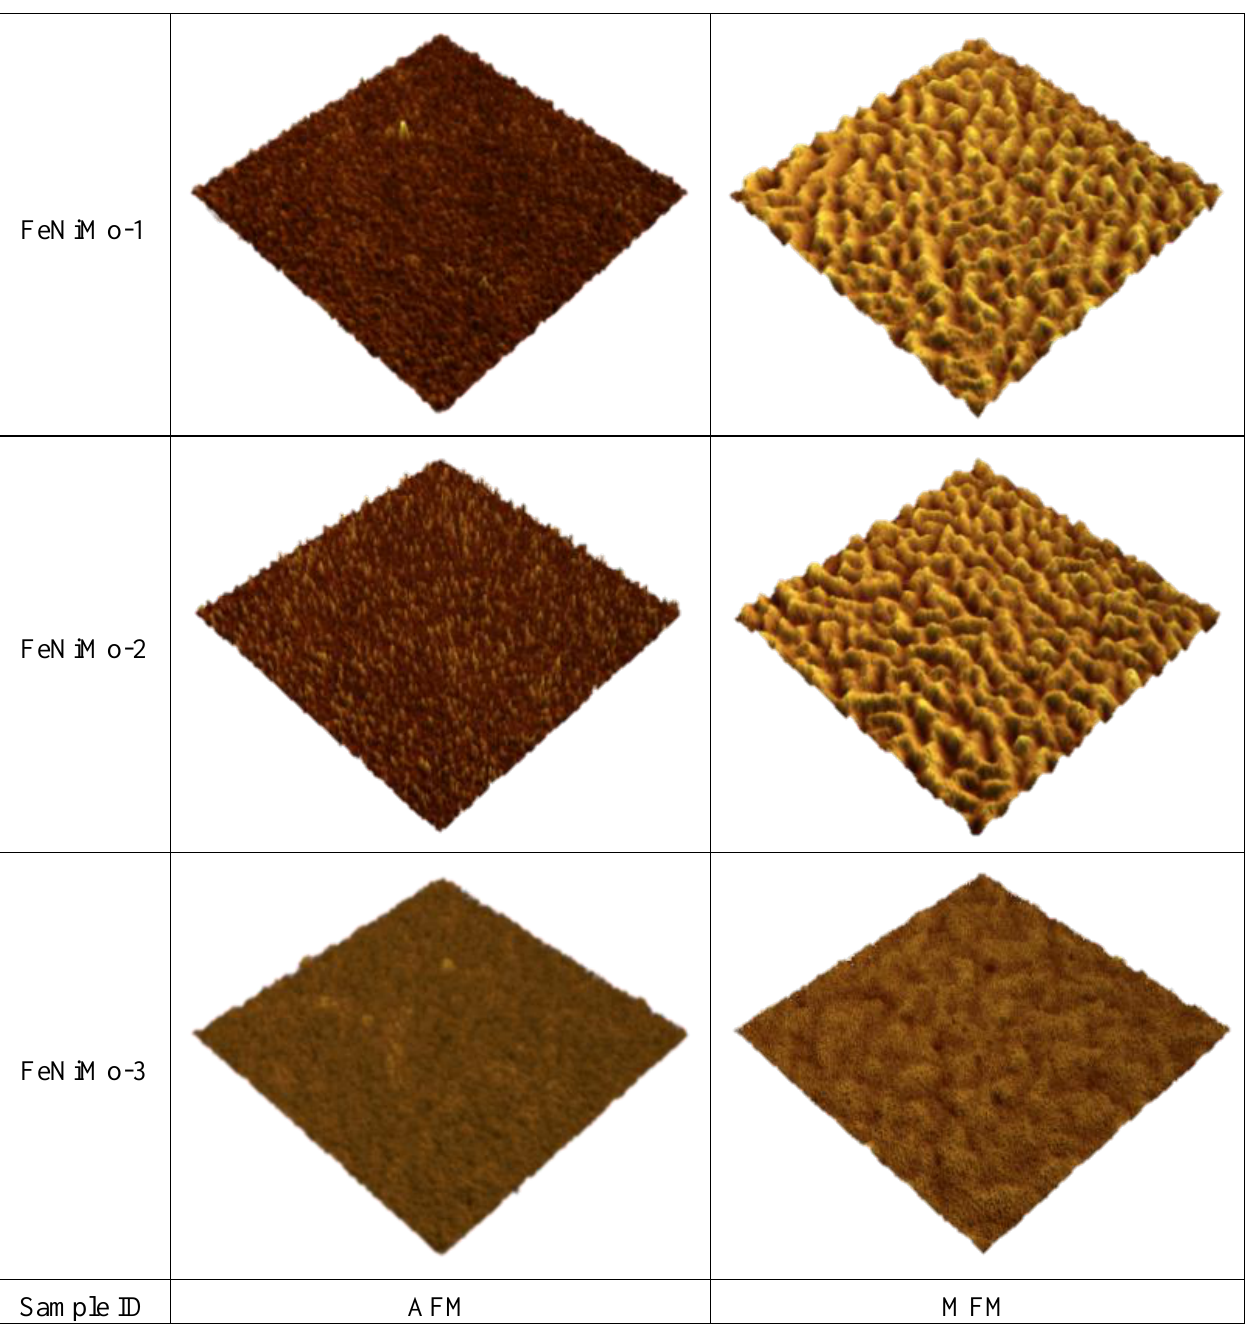
Figure 7. AFM and MFM images (size: 3 µm × 3 µm) of FeNiMo thin films in 3D visualization.